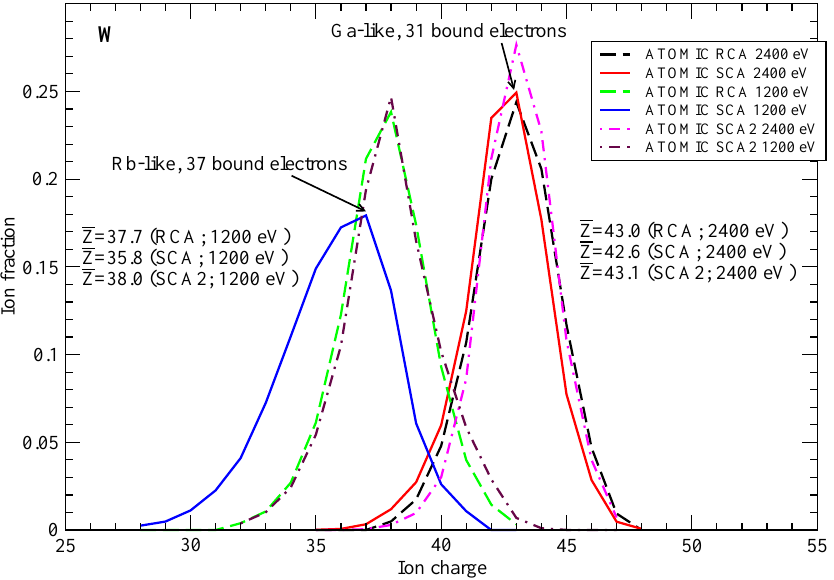
Figure 1. Ionization distribution of tungsten at two temperatures and an electron density of 10 14 cm − 3 : The left-most curves represent the ionization balance at a temperature of 1200 eV and the right-most curves represent the ionization balance at 2400 eV. We compare the ATOMIC semi-relativistic calculations (ATOMIC SCA) (solid lines) with the ATOMIC fully-relativistic calculations (ATOMIC RCA) (dashed lines). We also present an ATOMIC calculation (labelled SCA2, dot-dashed lines) that used the same configuration list as used in the ATOMIC RCA